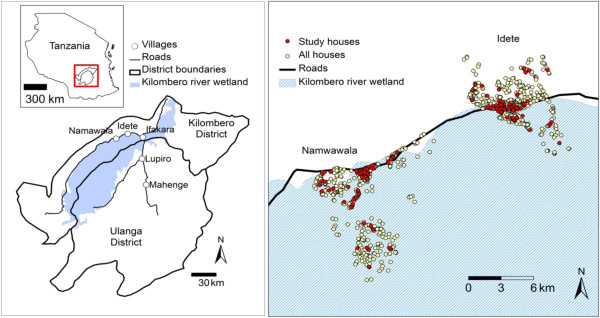
Kilombero and Ulanga districts (8.1°S and 36.6°E) in Tanzania showing Namwawala and Idete villages (left) and spatial distribution of sentinel houses used for mosquito sampling (right) [25].